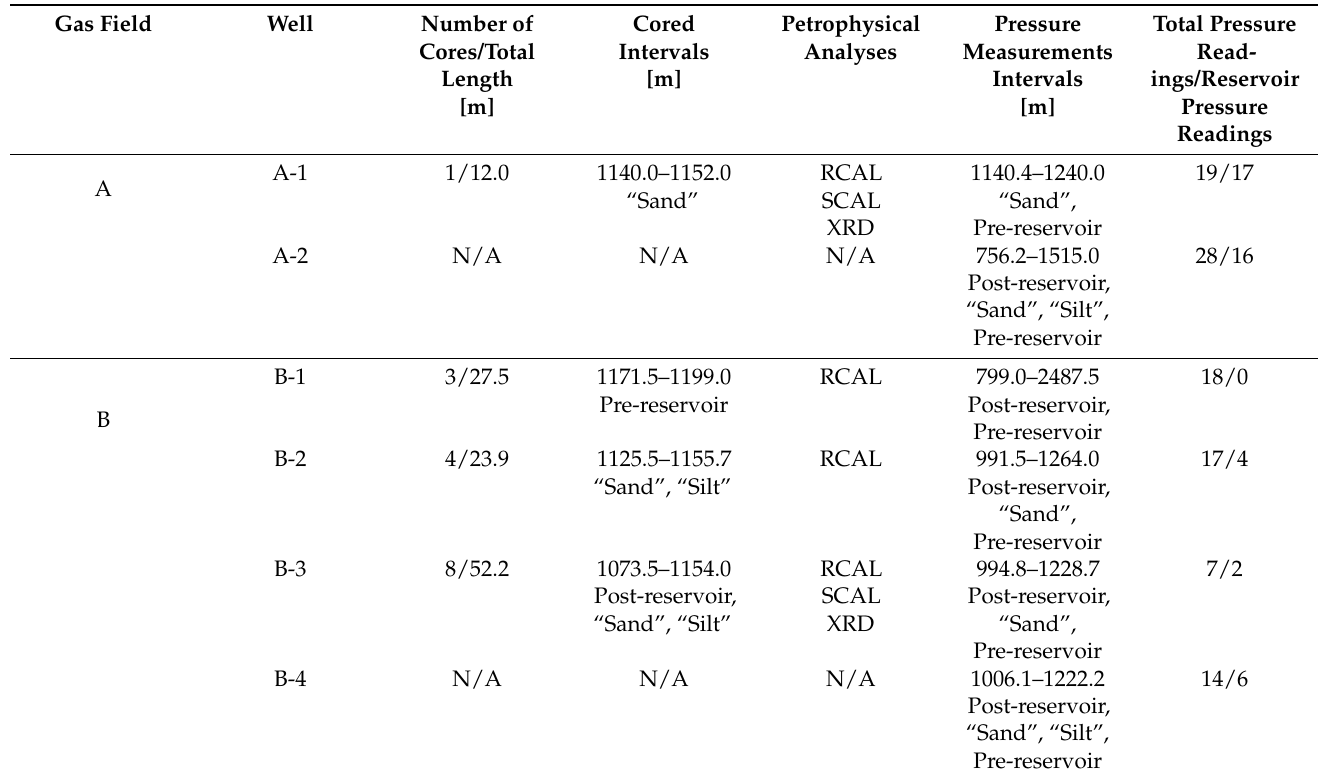
Table 1. Conventional coring program and wireline formation pressure measurements conducted in the analyzed gas exploration